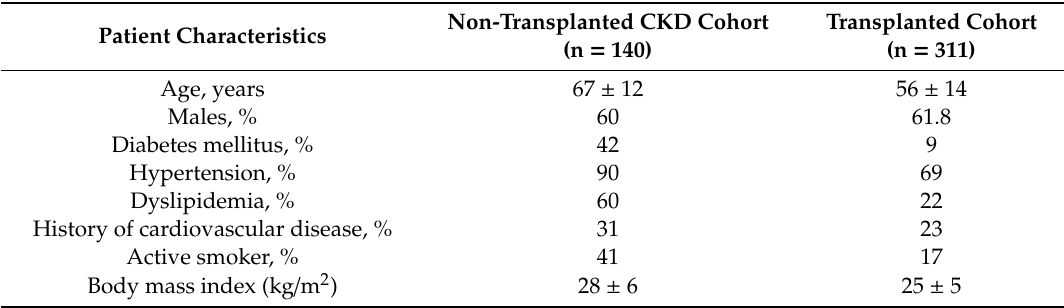
Table 1. Characteristics of the study